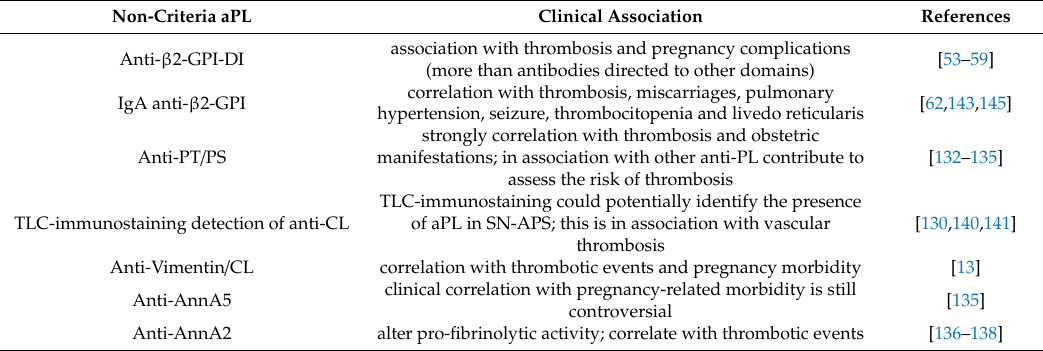
Table 1. Di ff erent non-criteria specificities in seronegative Antiphospholipid Syndrome (SN-APS).